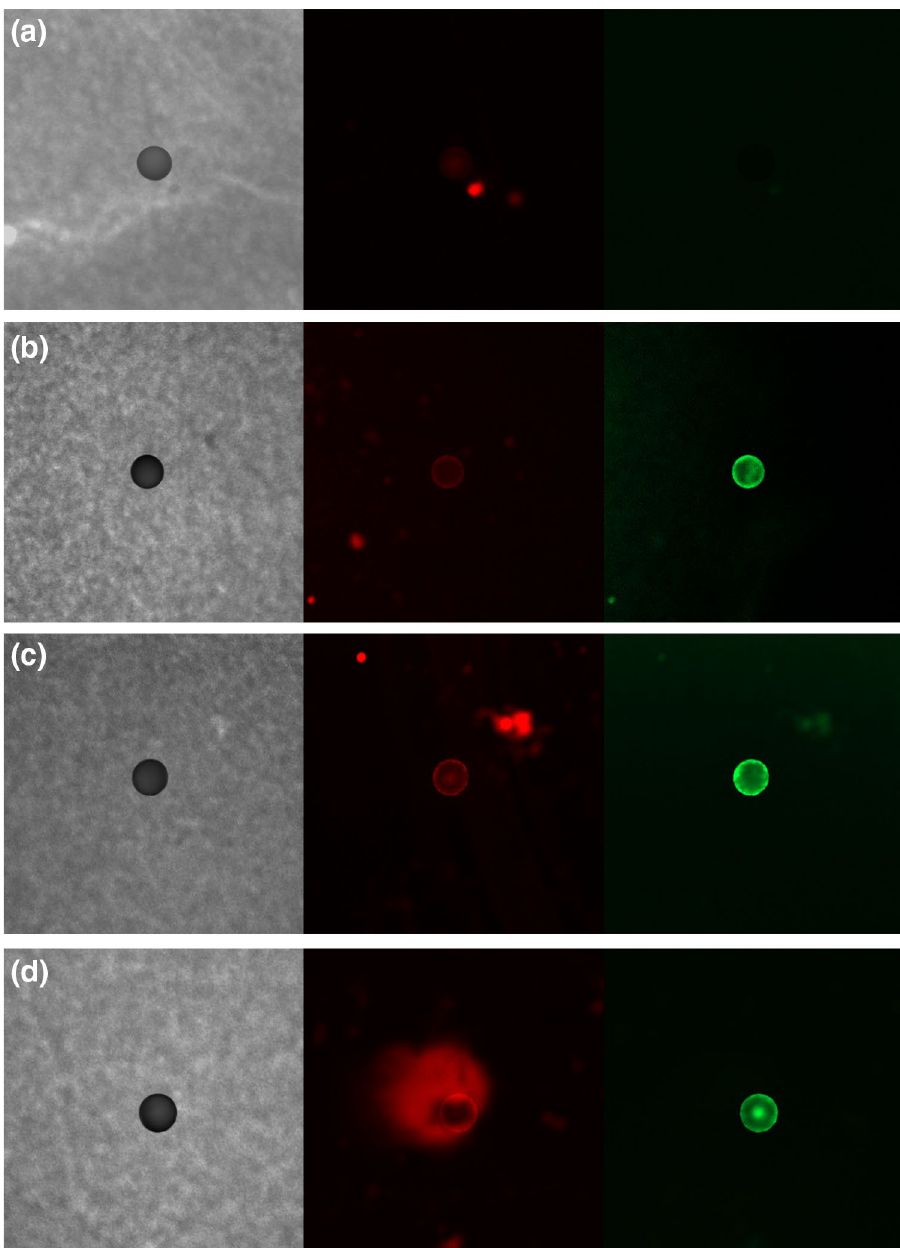
Figure 6. Fluorescent images of PE microspheres stained using NR concentrations of ( a ) 1 μg/ml, ( b ) 5 μg/ml, ( c ) 10 μg/ml and ( d ) 20